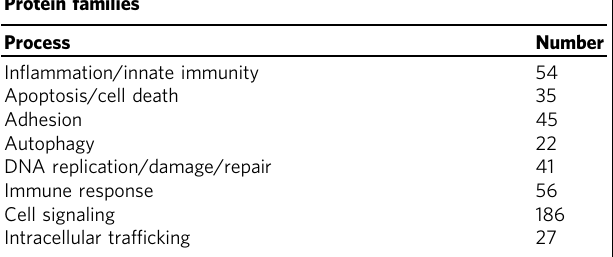
Table 2 Number of identi fi ed proteins belonging to the indicated functional families